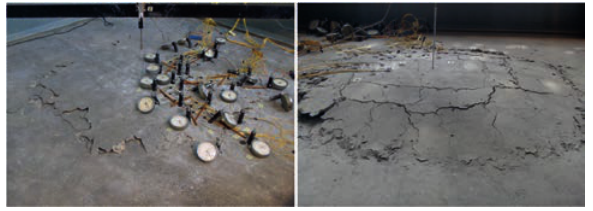
slabsa) sudden for RC slab b) plastic for SFRC slab Fig. 8. Failure mode of